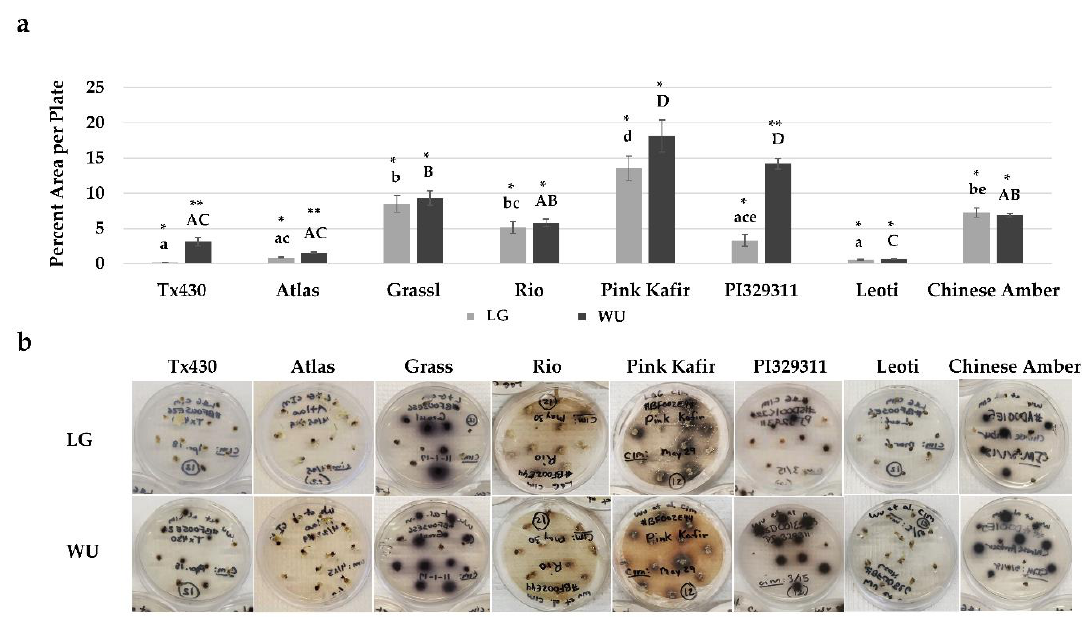
Figure 2. Impact of LG and WU CIM on medium browning from immature embryo explants of diverse sorghum genotypes, following two weeks of culture on CIM. ( a ) Digital images were analyzed as described in the Materials and Methods and plotted as the mean area per petri plate (± SE) exhibiting medium browning. ( b ) Representative photos of petri plates for each genotype and protocol combination illustrating the levels of medium browning. Data shown in ( a ) were analyzed by one-way ANOVA, and tested for significance using Tukey’s HSD Post-hoc Test. For comparisons across genotypes for LG CIM, those with the same lowercase letter are not significantly different at p ≤ 0.05. For comparisons across genotypes for WU CIM, those with the same uppercase letter are not significantly different at p ≤ 0.05. For comparisons across the two media within a genotype, those with the same asterisk pattern are not significantly different at p ≤ 0.05.